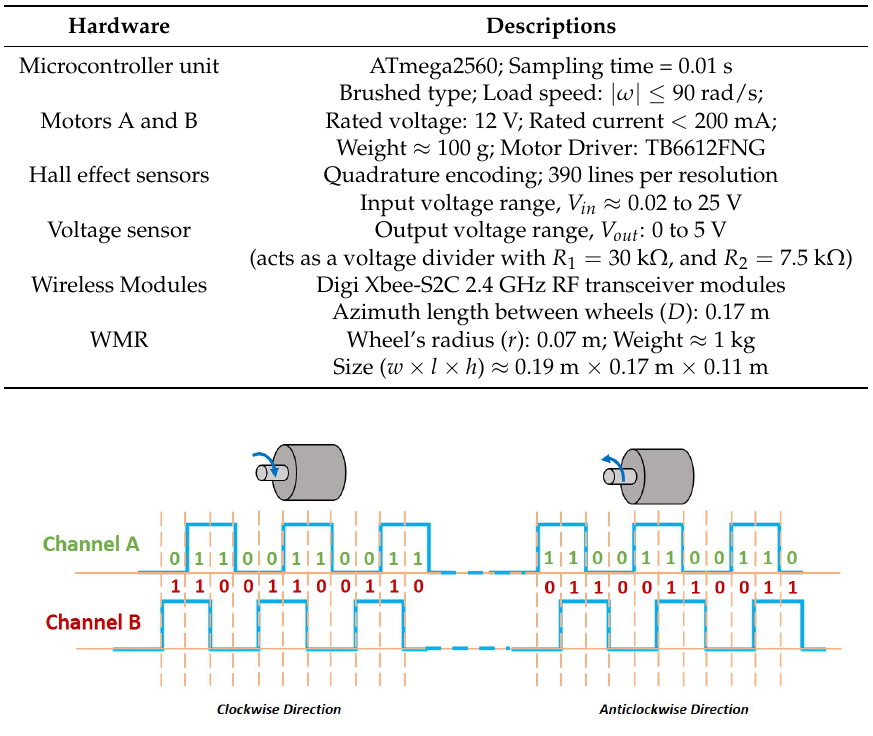
Figure 7. Quadrature encoding with hall effect sensors. Both channels will output square waves that are 90 ◦ out of phase, which allow for both speed and direction to be